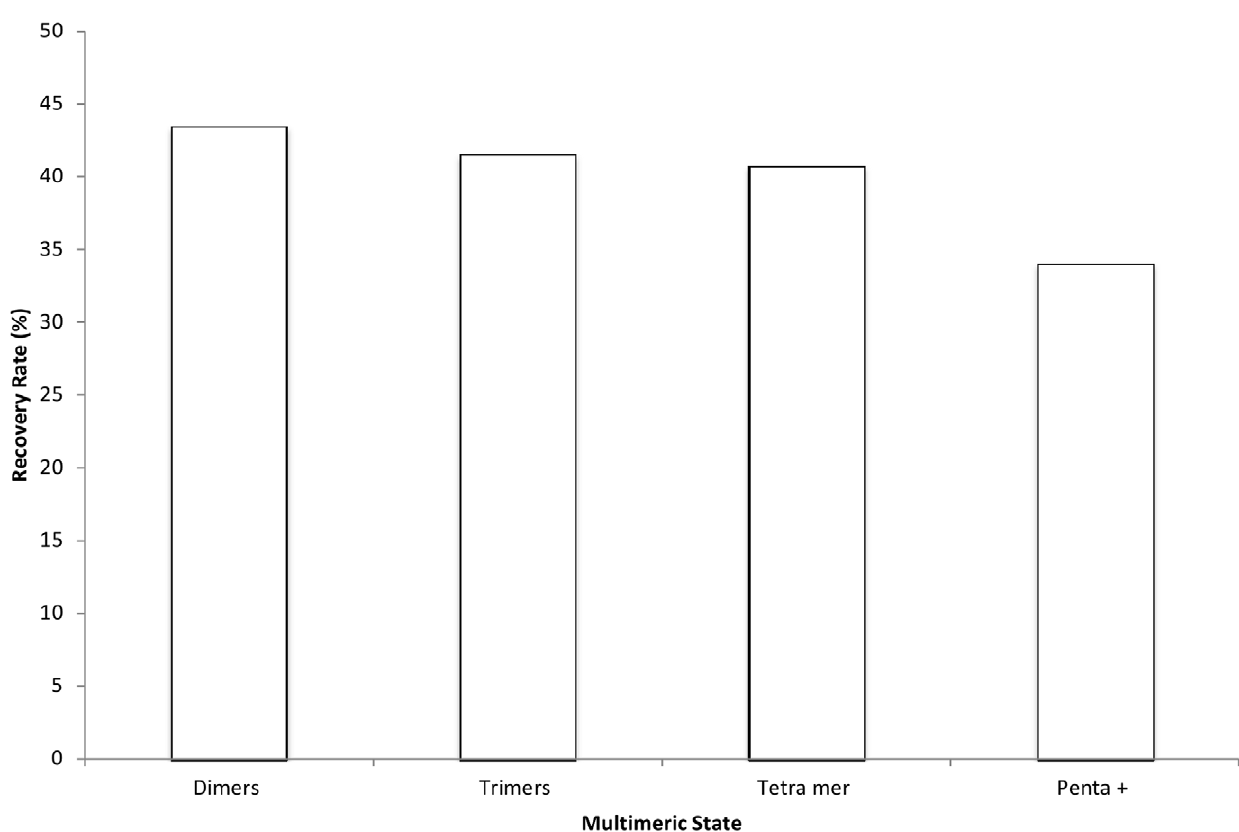
Figure 2. Reconstructing biounits by homology inference. Recovery of those homooligomeric interfaces by IBIS which can only be produced by applying crystallographic symmetry operations to PDB ASU. Recovery rate is calculated as a number of binding site residues identified by both PISA and IBIS divided by the number of binding site residues identified by PISA by applying crystallographic symmetry operations.